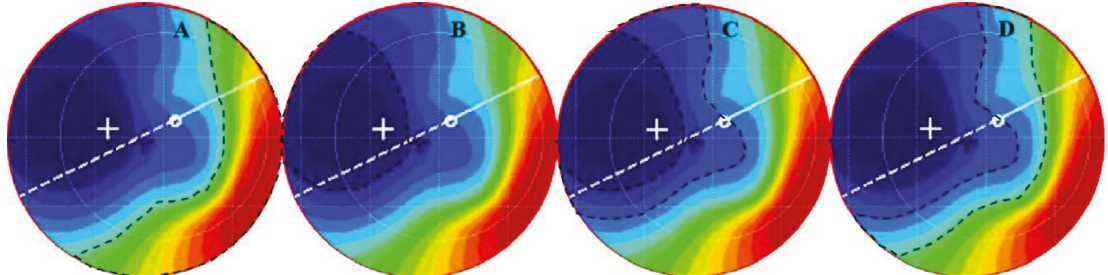
Figure 1: Areas of different refractive powers in the central 4 mm pupillary area ((a) positive-power area, (b) overcorrected area, (c) corrected area, and (d) undercorrected area).